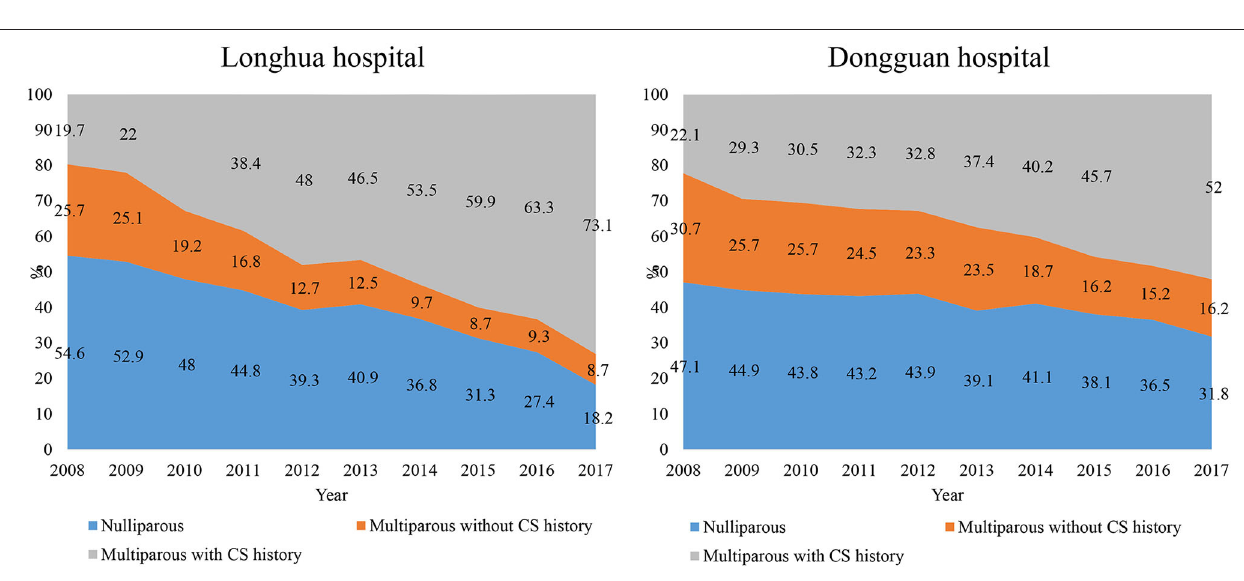
FIGURE 4 | Trends in composition of CS by parity and history of CS in 10 years from 2008 to 2017 in two